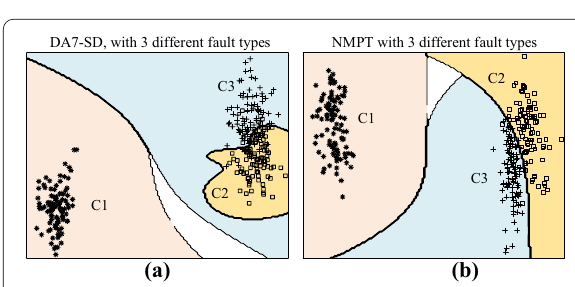
Figure 6 Classification hyperplane of DA7-SD: a Original DA7-SD; b After model parameter